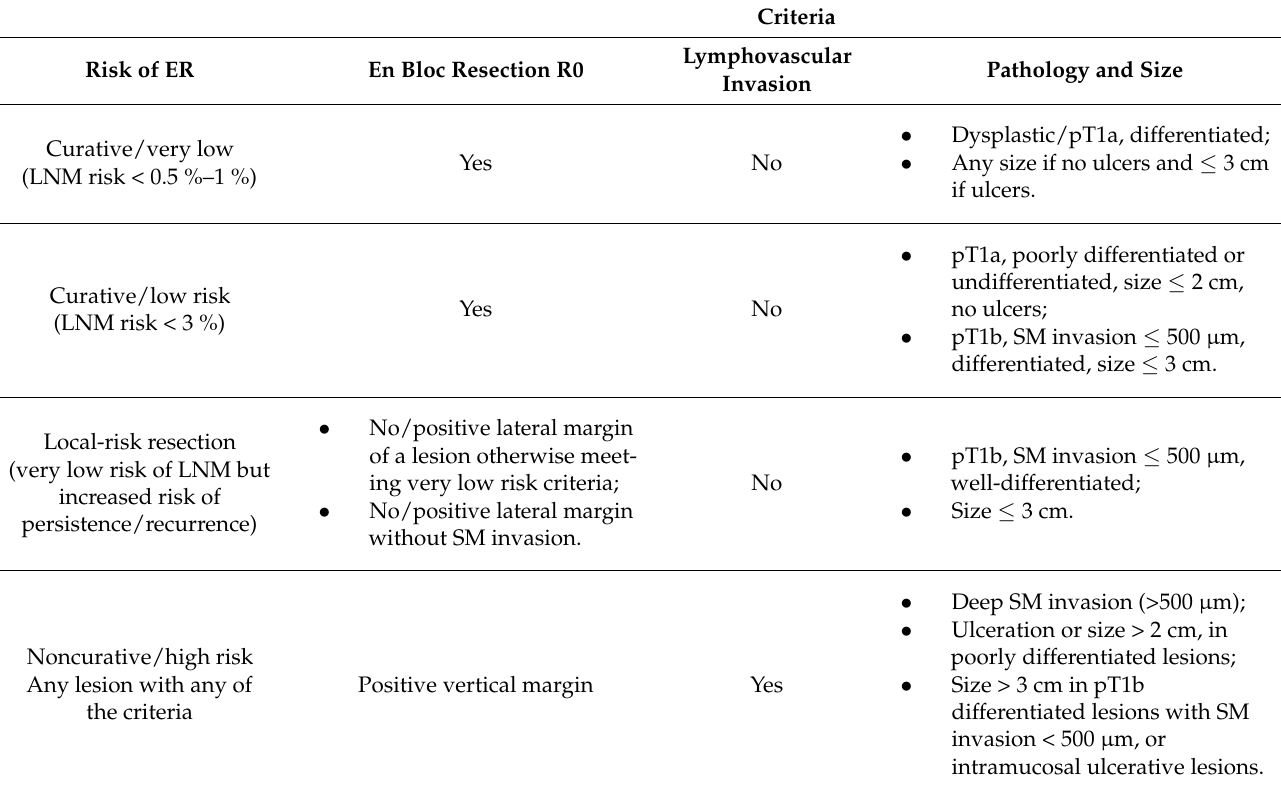
Table 5. Criteria for curativeness of ER